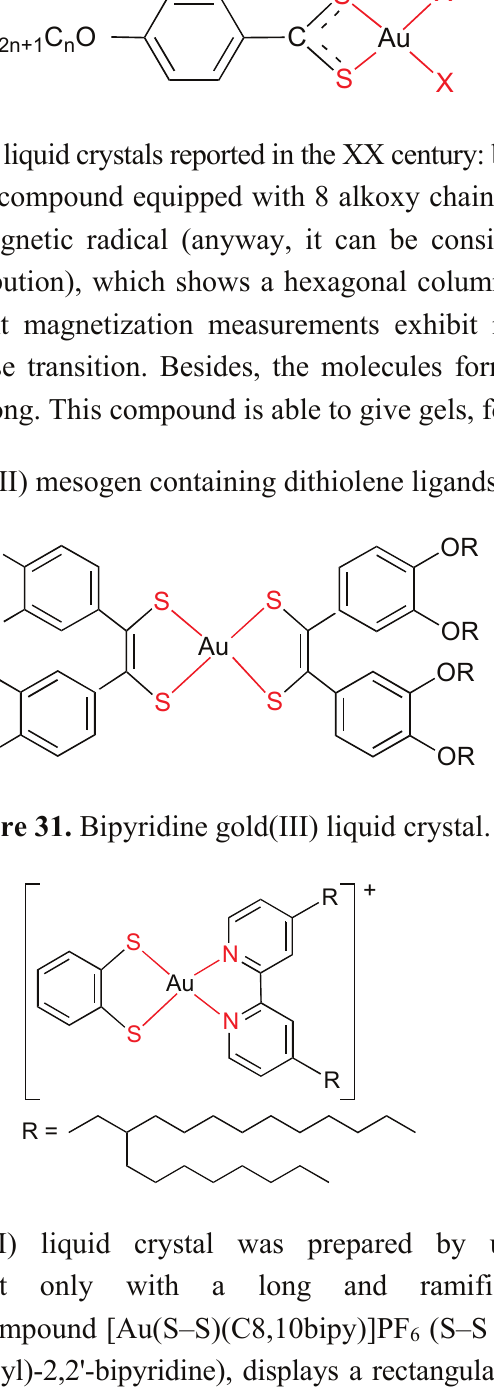
C8,10bipy = 4,4'-di-(3-octyltridecyl)-2,2'-bipyridine), displays a rectangular columnar liquid